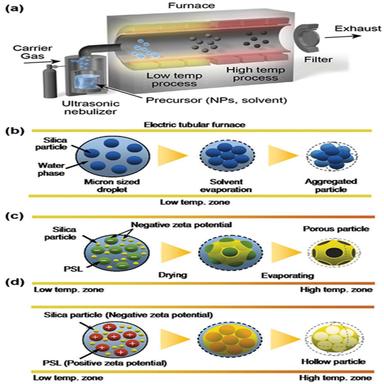
(a) Schematic outlining the principle of the spray-drying process; Formation of (a) dense, (b) porous, and (c) hollow particles. Reprinted (adapted) with permission from (ACS Nano 2010; 4 (8); 4717–4724). Copyright © 2010, American Chemical Society).